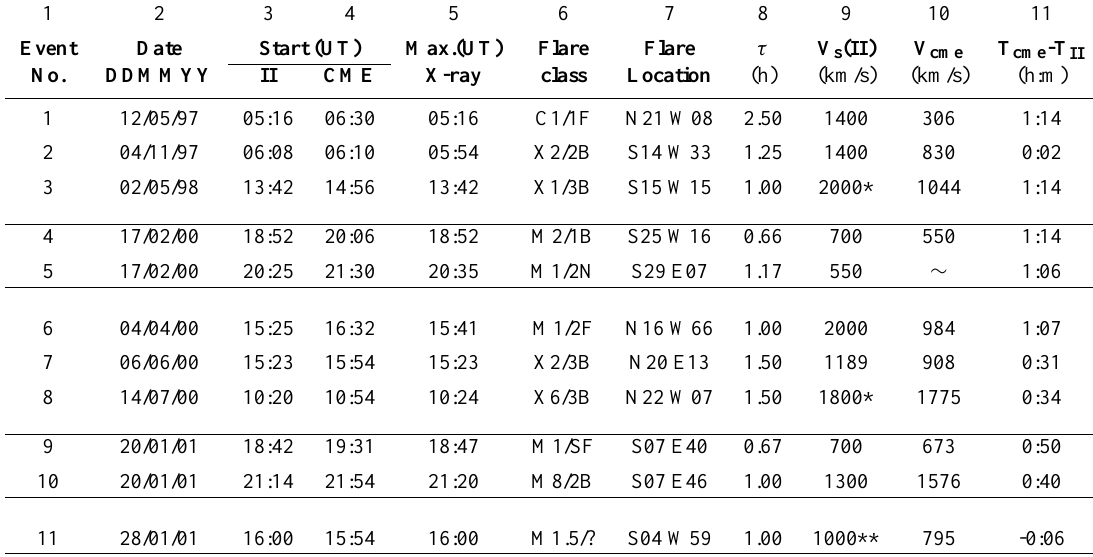
Table 1. Characteristics of eleven solar flares with accompanying Metric Type II and Halo